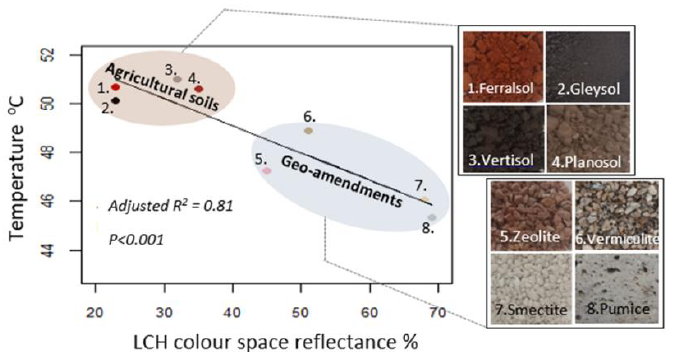
Figure 4. Relationship between surface temperature and LCH (lightness/reflectance, chroma, hue) colour space reflectance properties of four common cropping soils and four reflective geo-materials. The surface temperatures are averages taken over a 2-hour period with an ambient air temperature of 37.1 °C.